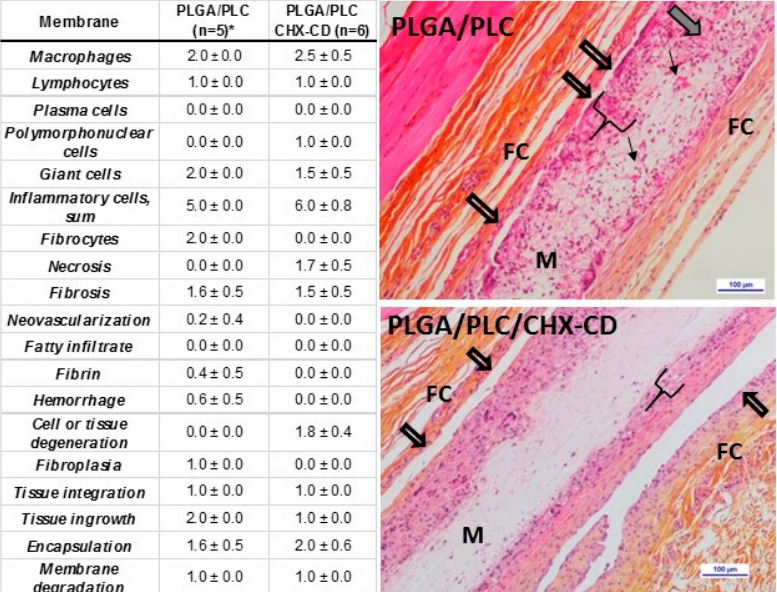
Figure 11. Semi-quantitative histopathologic analysis table (n = number of membranes analyzed, mean ± SD) after 20 days of sub-cutaneous implantation and photomicrographs of the implanted membranes. Legend: allow arrows: no local tissue integration, bracket: extend of cells tissue ingrowth, black arrows: neovessels, grey arrow: active fibroblasts, M: membrane, FC: Fibrous encapsulation. * One sample was damaged during the technical preparation.